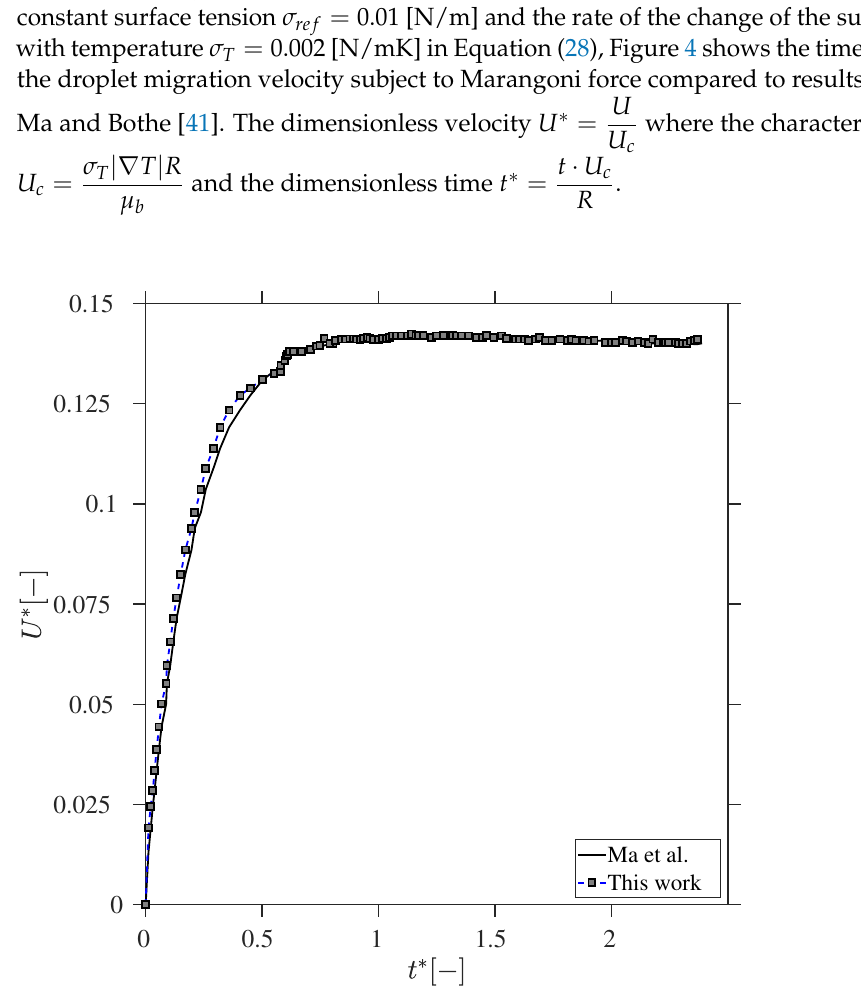
Figure 4. Comparison between droplet migration velocity in this work and Ma and Bothe